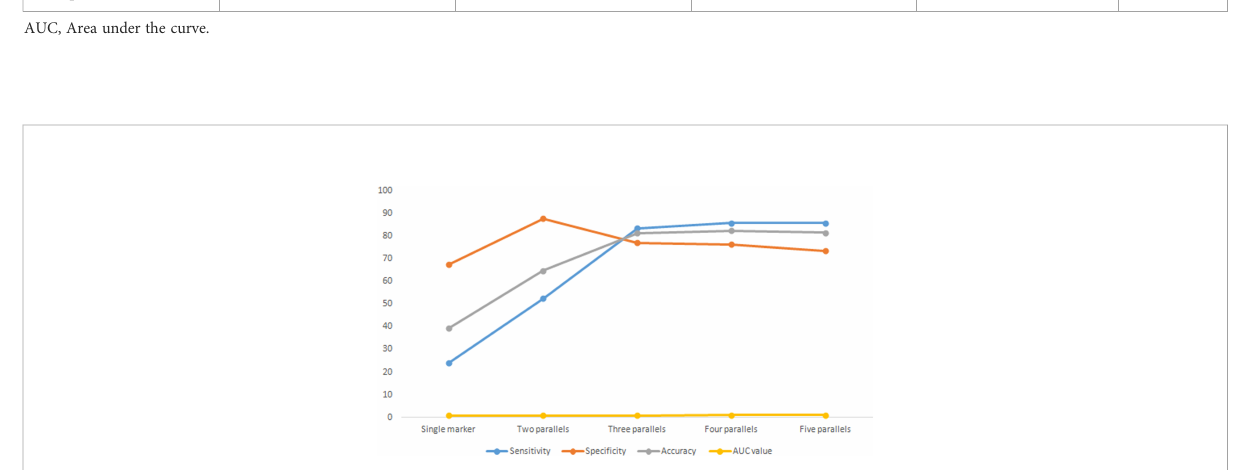
FIGURE 1 Diagnosis results of fi ve tumor markers by different parallel